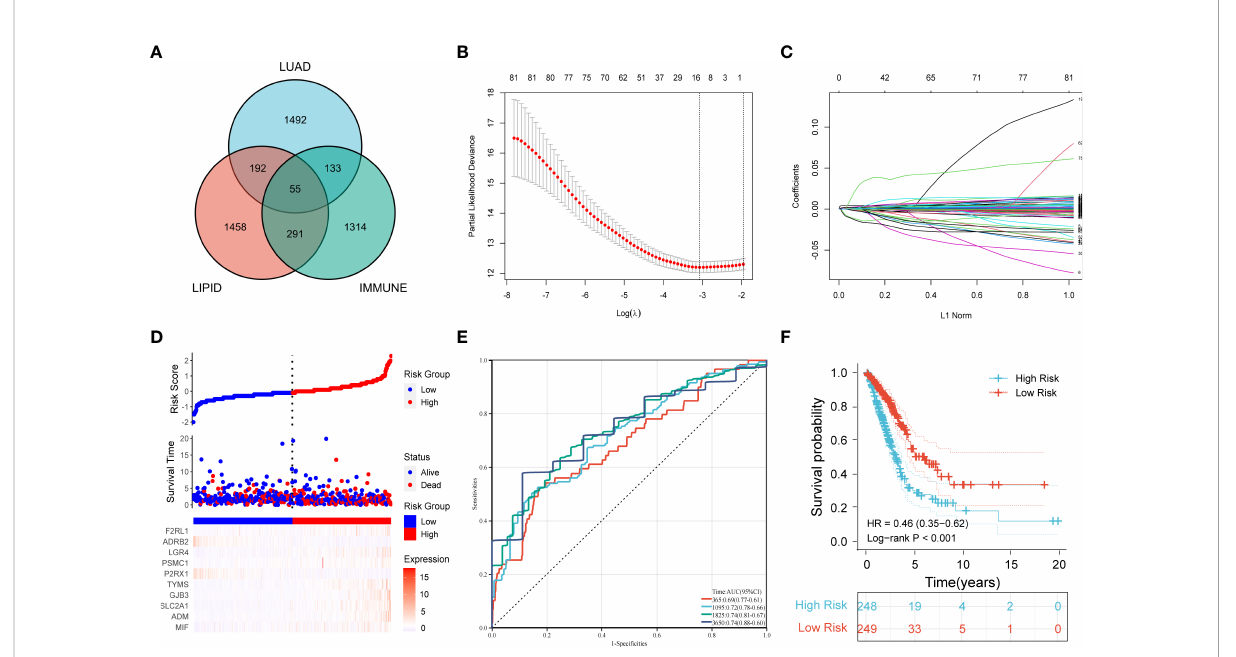
FIGURE 3 Construction of a prognostic model for LUAD patients based on immune-related and lipid metabolism-related DEGs. (A) The Venn diagram displays the intersection of common genes among LUAD-related DEGs and lipid metabolism-related and immune-related genes. (B) The LASSO regression algorithm was used to select the optimal variable ( l ) with a 10-fold cross-validation method. (C) The solution path was plotted according to coef fi cients against the L1 norm. (D) The distribution of risk score, survival status, and the expression levels of coef fi cients in the prognostic signature. (E) The time-dependent ROC curves for the prognostic signature in the TCGA cohort. (F) The overall survival curves of LUAD patients with high- and low-risk scores were plotted based on the prognostic